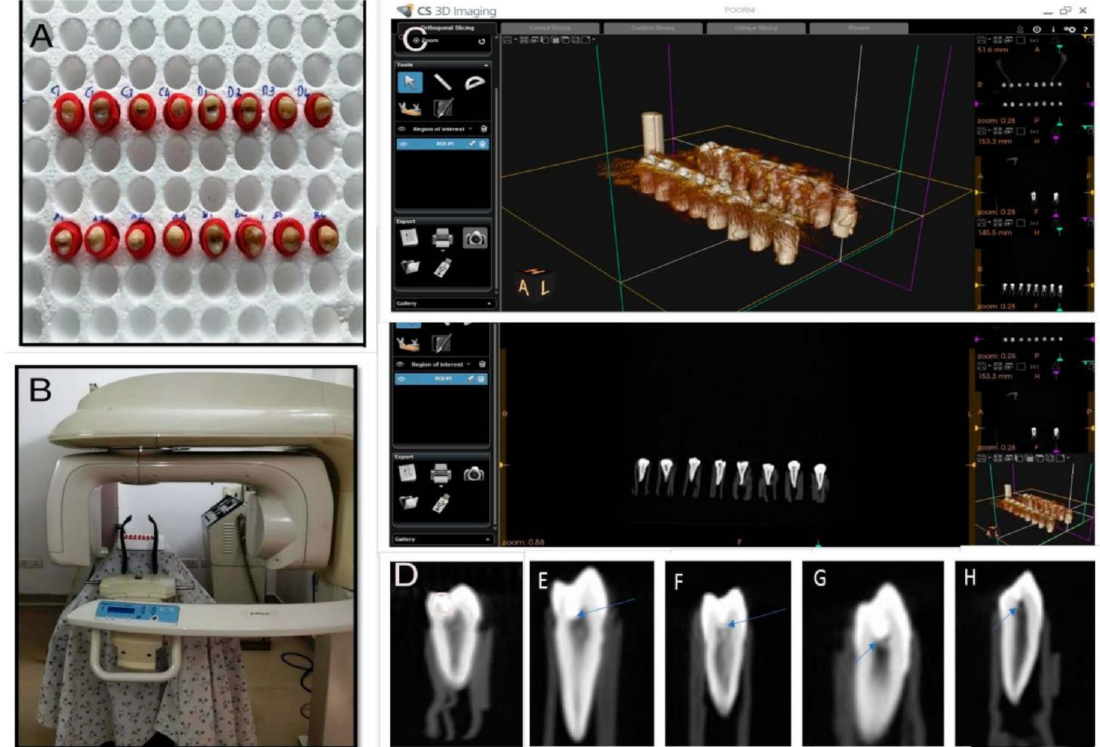
Figure 2. ( A , B ) Computed tomography (CT) imaging of the extracted teeth; ( C ) CT imaging software with tools; dentinal bridge formation (blue arrows) in negative control (( D ) no bridge), EndoSequence root repair material (ERRM) (( E ) complete bridge), mineral trioxide aggregate (MTA) (( F ) complete bridge), Biodentine (( G ) partial bridge) and calcium hydroxide (( H ) partial